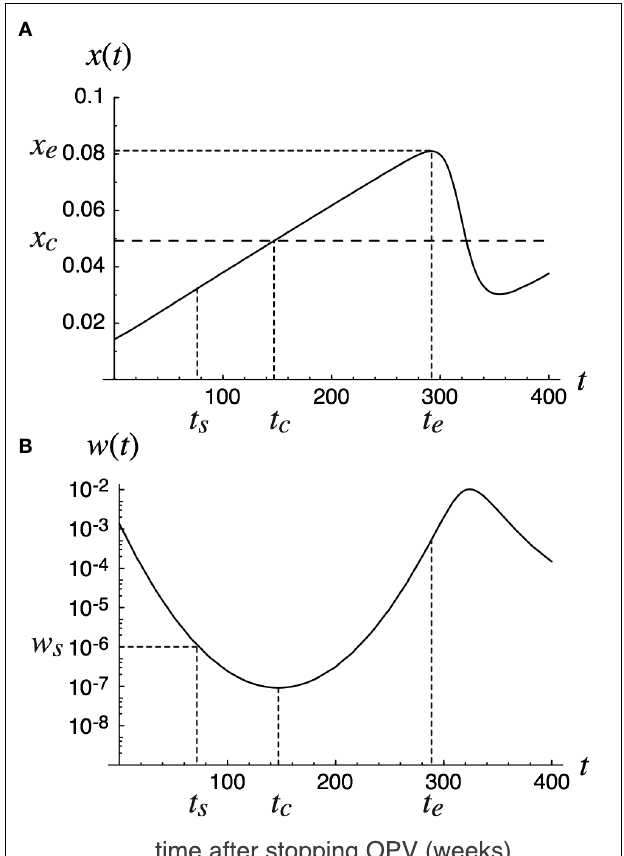
FIGURE 3 | Deterministic trajectory after stopping OPV. Deterministic trajectory of epidemiological dynamics (8) in the text.The fraction x ( t ) of susceptibles (A) and the fraction w ( t ) of infecteds (B) are plotted as functions of the time t = 0 since the cessation of OPV.The dotted line indicates the threshold host density for outbreak: x c = ( u + γ )/ β .The initial fractions x 0 and w 0 at time t = 0 are assumed to be in endemic equilibrium under OPV immunization to a constant fraction, p , of newborns.The time t = t c at which the fraction of infecteds is minimized in deterministic trajectory is indicated, together with time t = t s and t = t e defined for the calculation of the global eradication probability (Eq. 11). Parameters are: p = 0.7, β = 3.7, γ = 0.18, u =